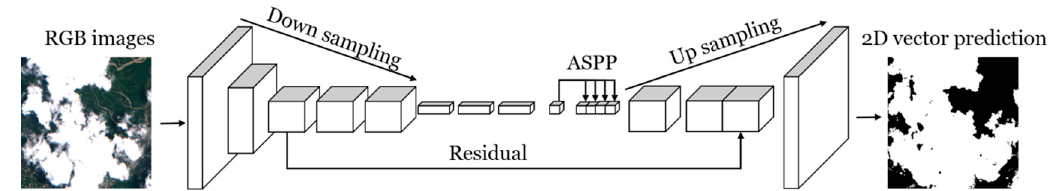
Figure 6. Illustration of the Deeplab v3+ architecture for cloud classification.